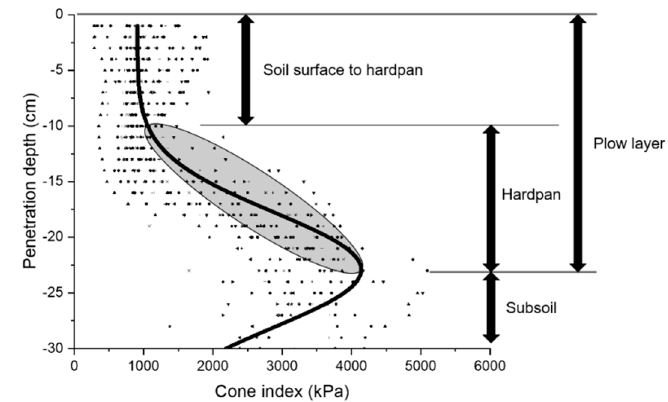
Figure 5. Analysis of cone penetration test results of 30 repeated measurements using a cone penetrometer. Table 3. Measured soil properties according to soil depth.